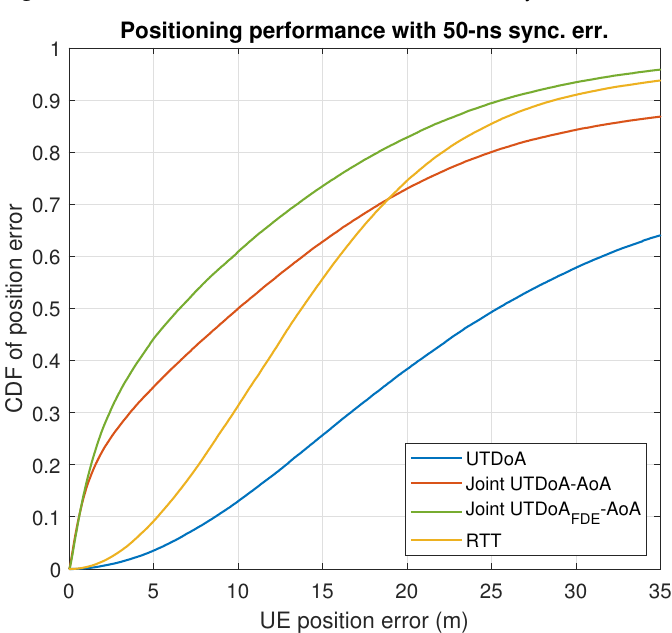
Figure 6. Results for 50 MHz bandwidth with 50 ns sync.